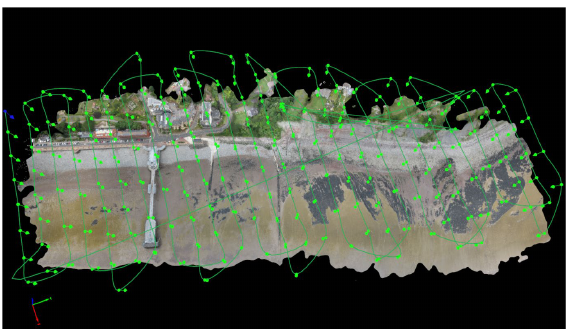
Figure 7 – 2016 DSM with 2015 Orthomasaic. On top is the 2016 DSM showing the areas of cut and fill and the 2015 Orthomosaic below. The red segments on the DSM are the areas of material loss and the blue segment are the areas of material gains.